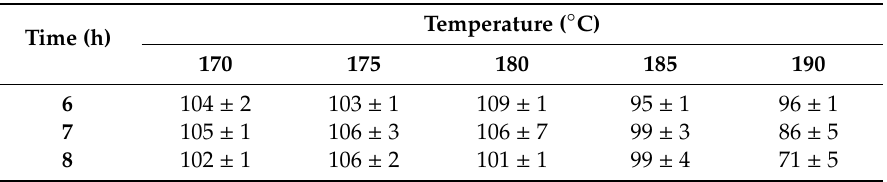
Table 2. HV 0.1 hardness obtained in profiles from AA 6005A powders extruded at 500 ° C and age hardened at different temperatures and time.